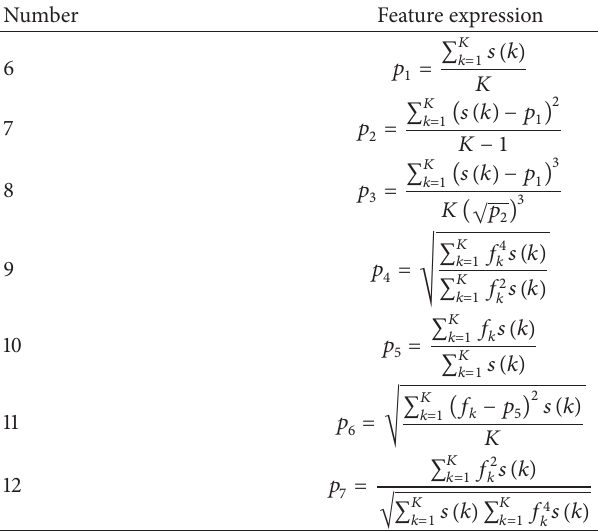
Figure 7. The decomposition process of vibration signals in other operating statuses is similar. The values of the statistical